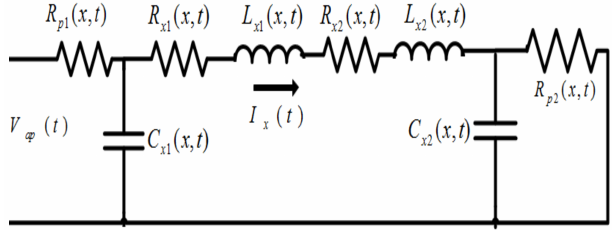
Figure 7. Representation as two arc model.